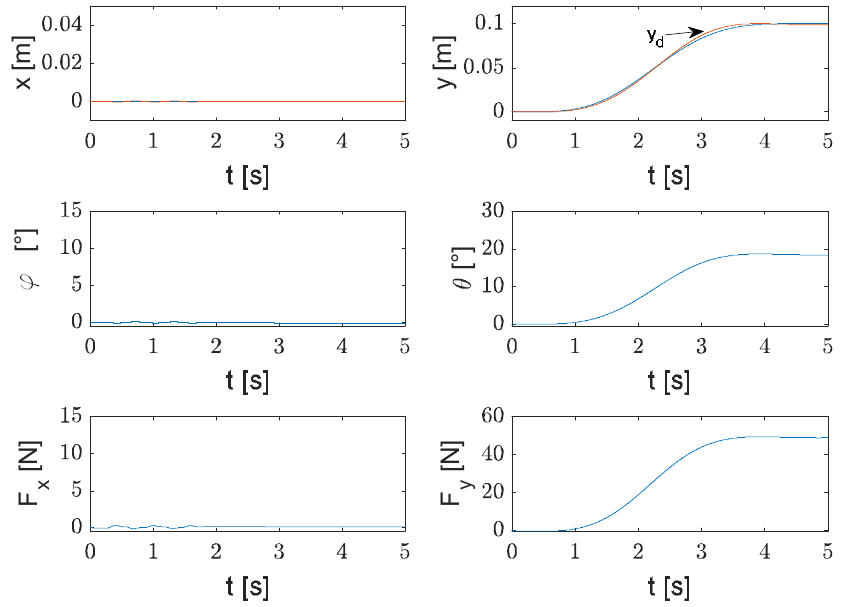
Figure 26. Response for a dorsiflexion movement φ = 18.4°, x = 0.1 m, with disturbance.